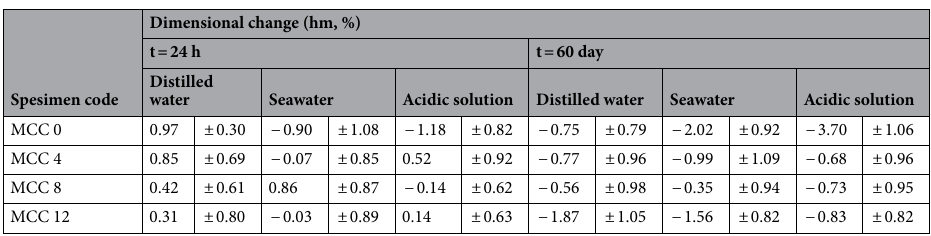
Table 5. The dimensions changes of composite (h m ) in the immersions distilled water, seawater, and acid water.